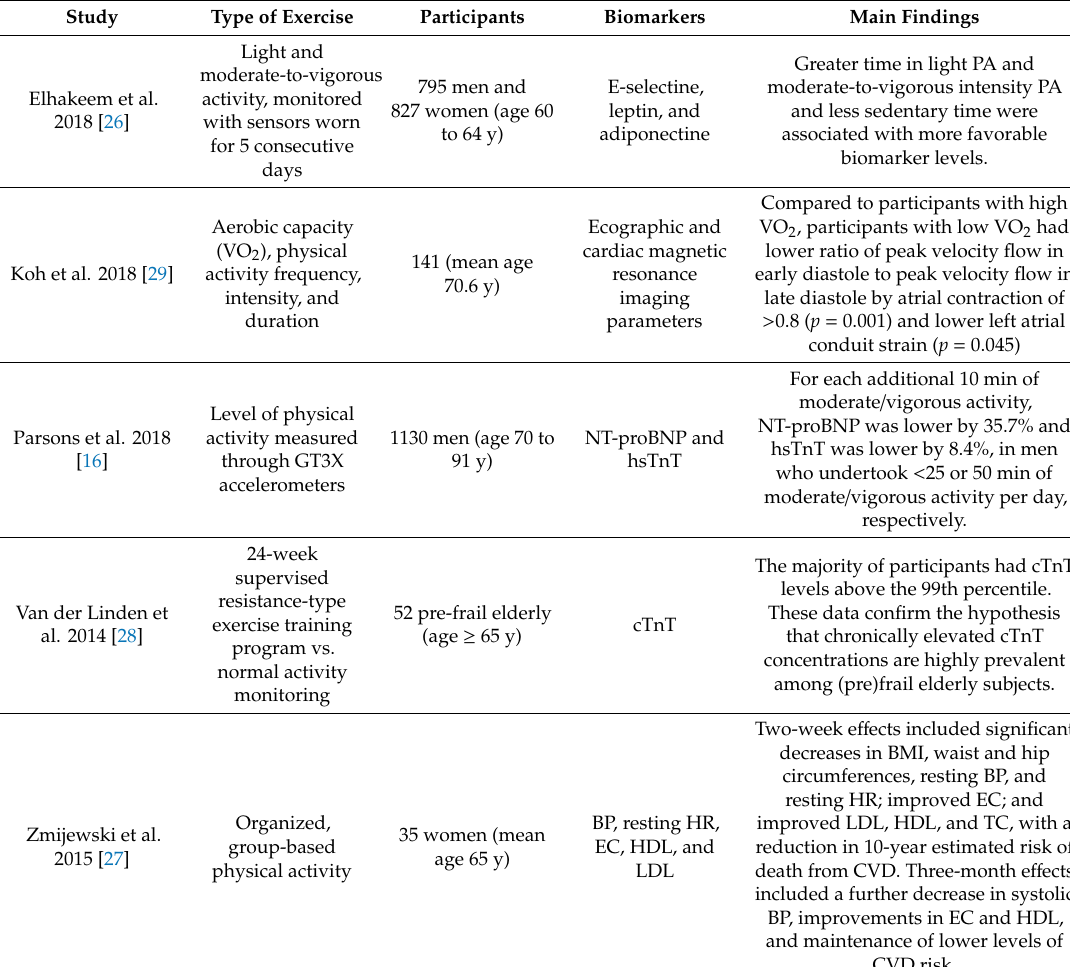
Table 2. Cardiovascular risk